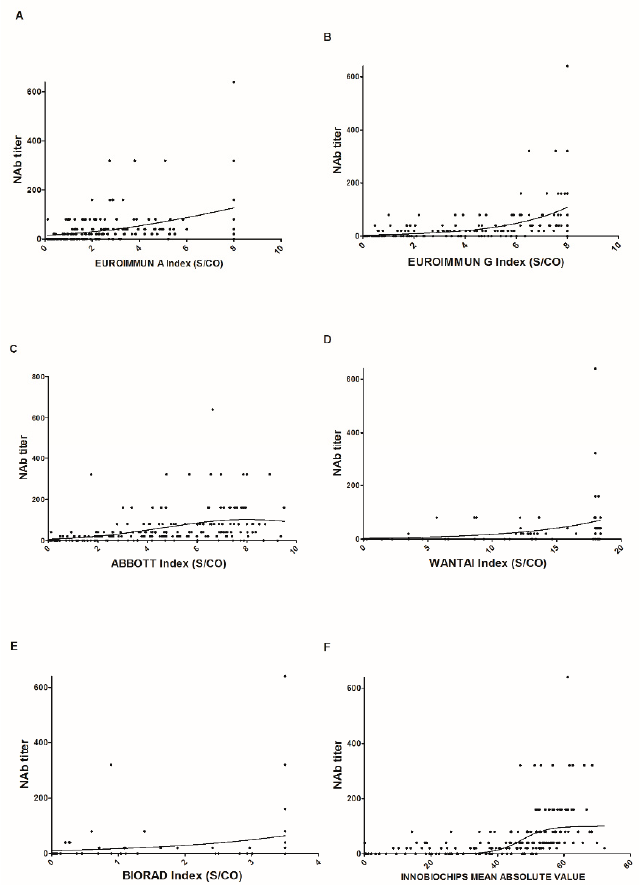
Figure 3. Relationship between the index values found for each assay and the neutralizing titers for the 208 samples ( A – F ). The solid lines represent the nonlinear fit of the neutralizing titles ac- cording to the indexes found for each assay.